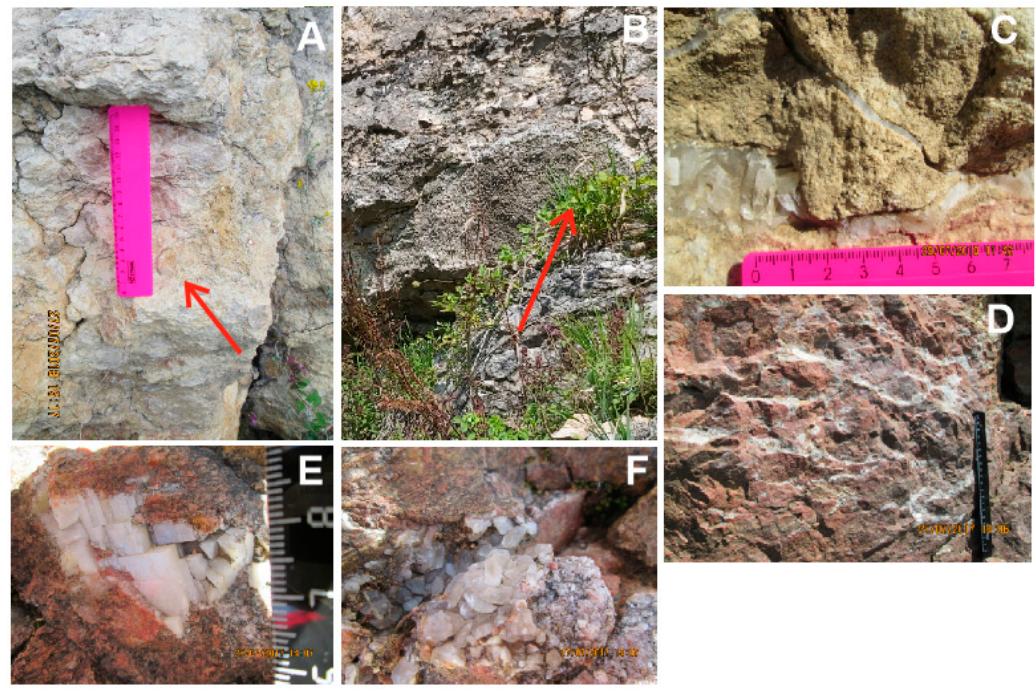
Figure 3. Some notable minor geological features of the Lagonaki Highland: ( A ) unidentified ammonite in the highly-fossiliferous Upper Jurassic limestones (Tender Cave locality), ( B ) calcite aggregate on the exposure of the Upper Jurassic limestones (5000 locality), ( C ) calcite veins in the megaclast of the Upper Jurassic limestones (Partisan Glade locality), and ( D – F ) the Upper Jurassic red dolostones with calcite veins (Big Azish Cave locality).